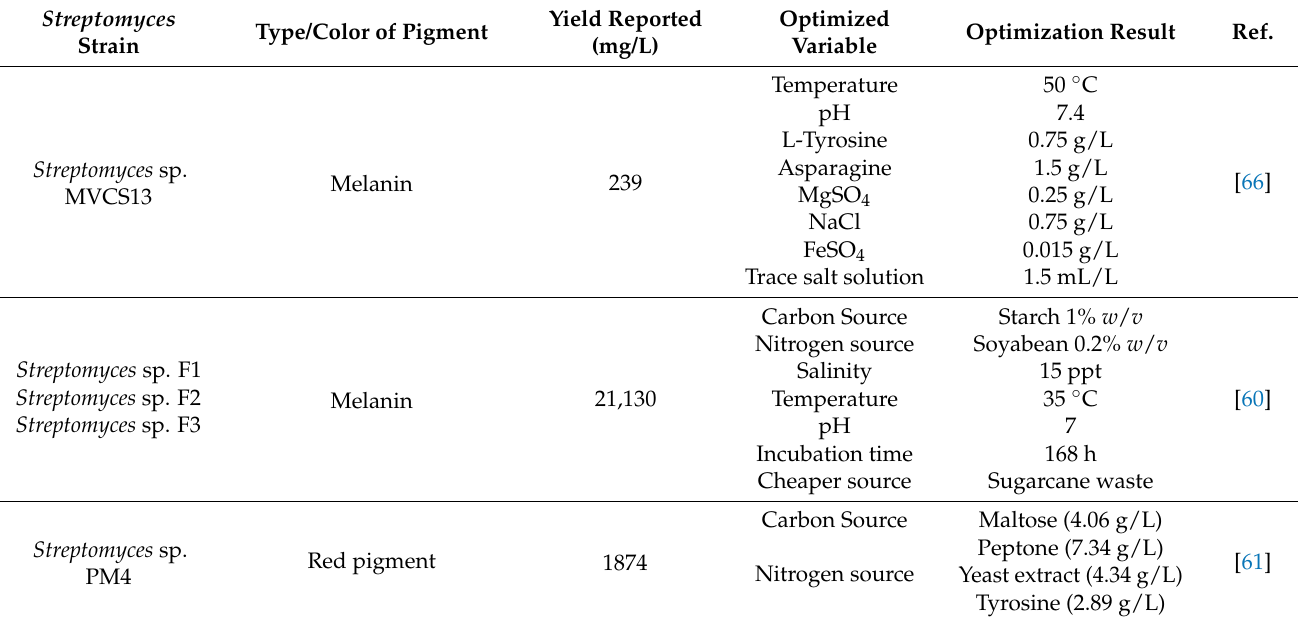
Table 4. Optimization conditions of pigments produced by each Streptomyces